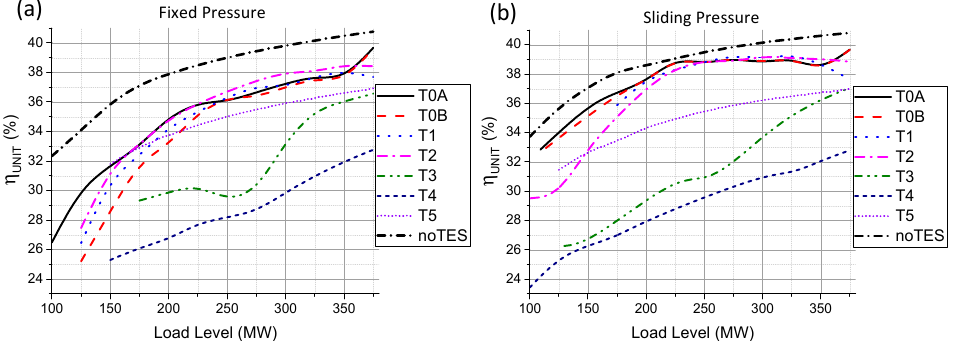
Figure 15. Unit efficiency ( η UNIT ) in FP ( a ) and SP ( b ) operating mode.